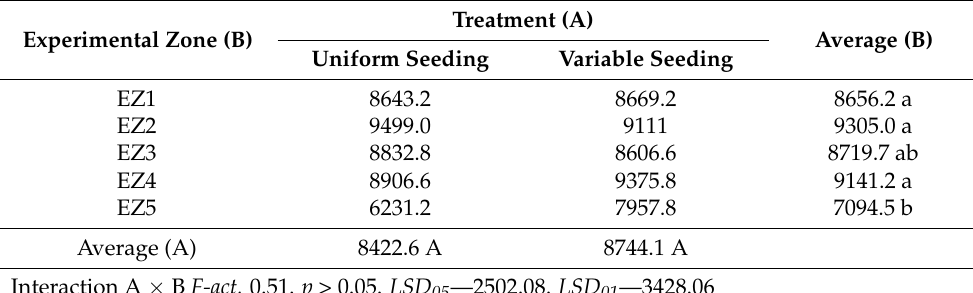
Table 8. Winter wheat grain yields in different zones and seeding treatments of the experiment (kg · ha − 1 ).